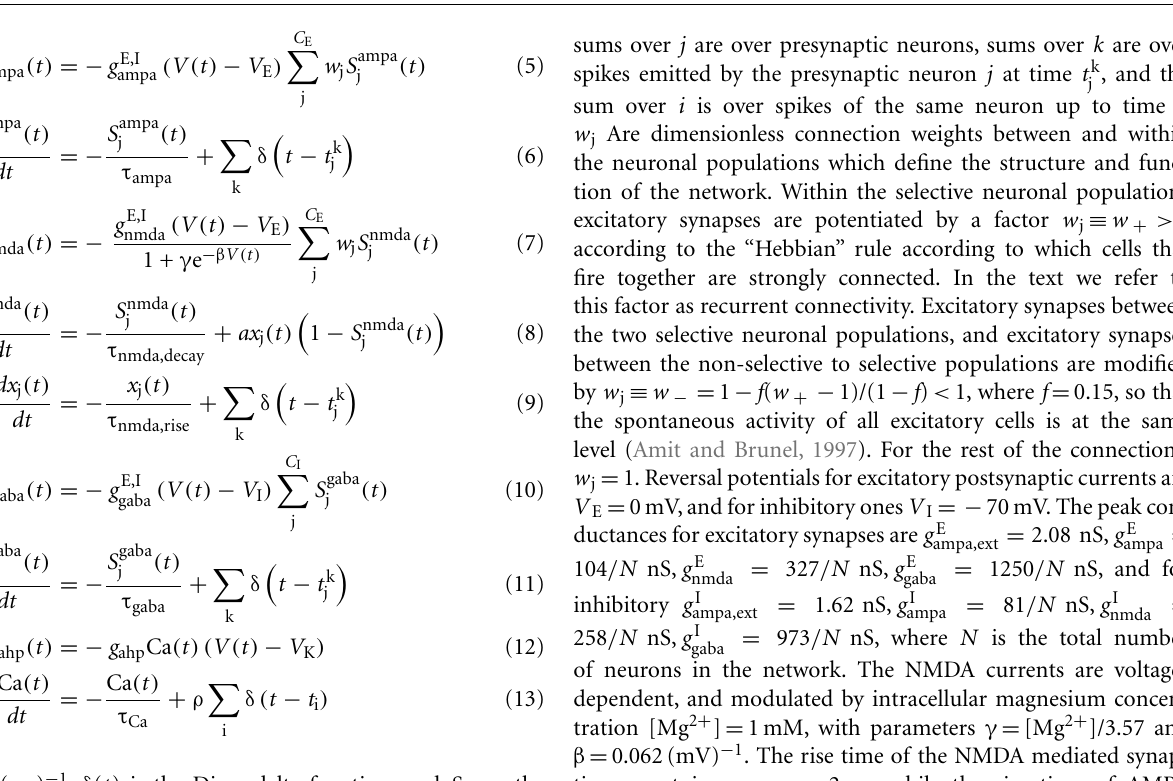
after hyperpolarizing currents with peak conductance g ahp . All neurons receive background input and selective populations receive an additional external stimulus λ 1 , λ 2 . (B) Assuming that the mean firing rate of the non-selective neuronal population is constant, the network is reduced into three neuronal populations: two excitatory (1, 2) and one inhibitory (I). (C) Four-variable reduced rate model of two populations with recurrent excitation, cross–inhibition, and neuronal